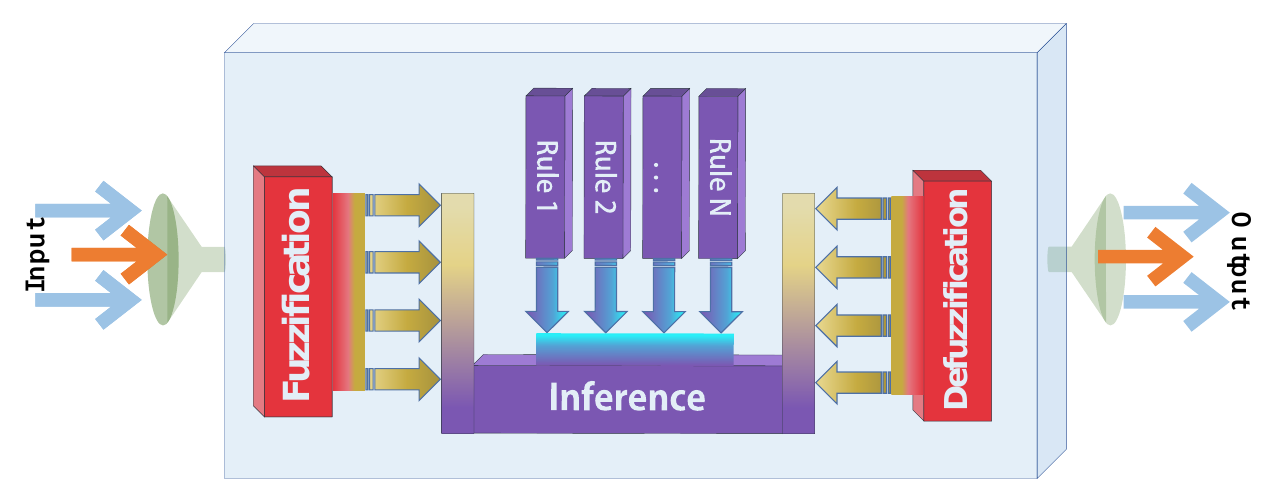
Figure 4. Fuzzy rule-based system